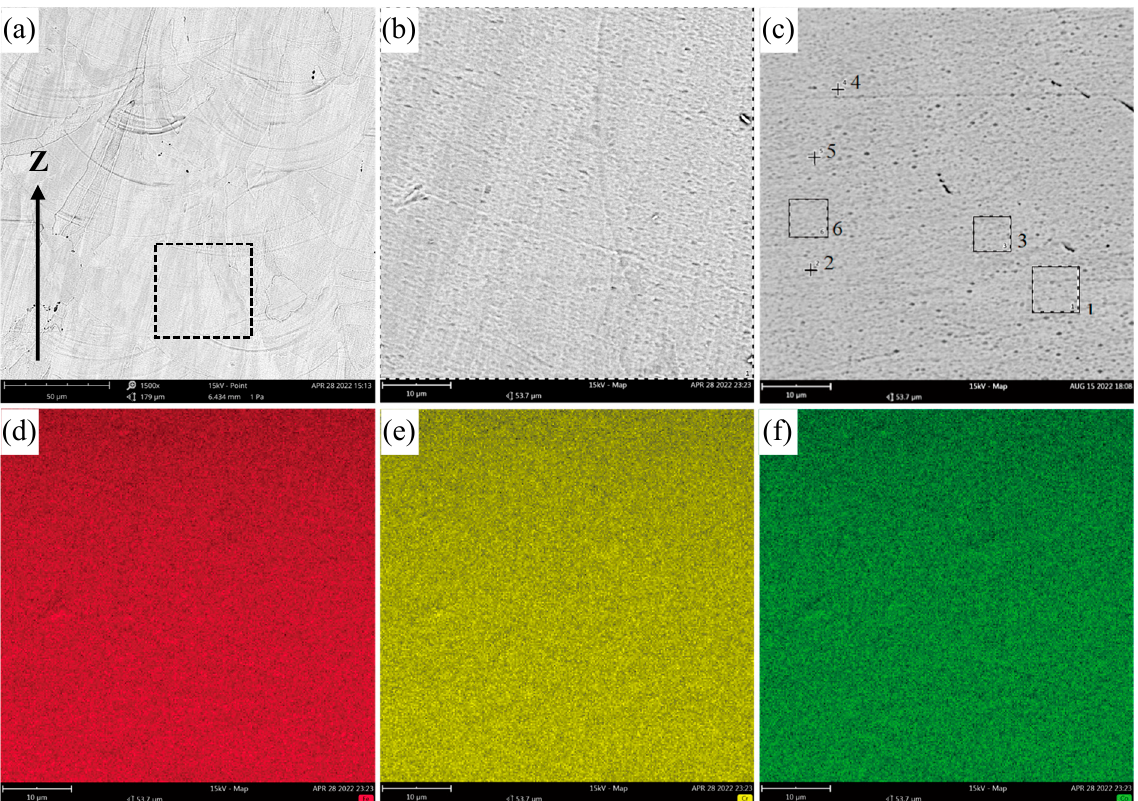
Figure 4. ( a ) SEM image of the as-built sample under the P3 process (Z direction). ( b ) Amplified SEM photographs in the virtual frame of ( a ). ( c ) Microregional component analysis. ( d – f ) EDS elemental mapping corresponding to ( b ), d: Fe, e: Cr, f: Co. Table 1. Chemical composition of microregions marked in Figure 4c.